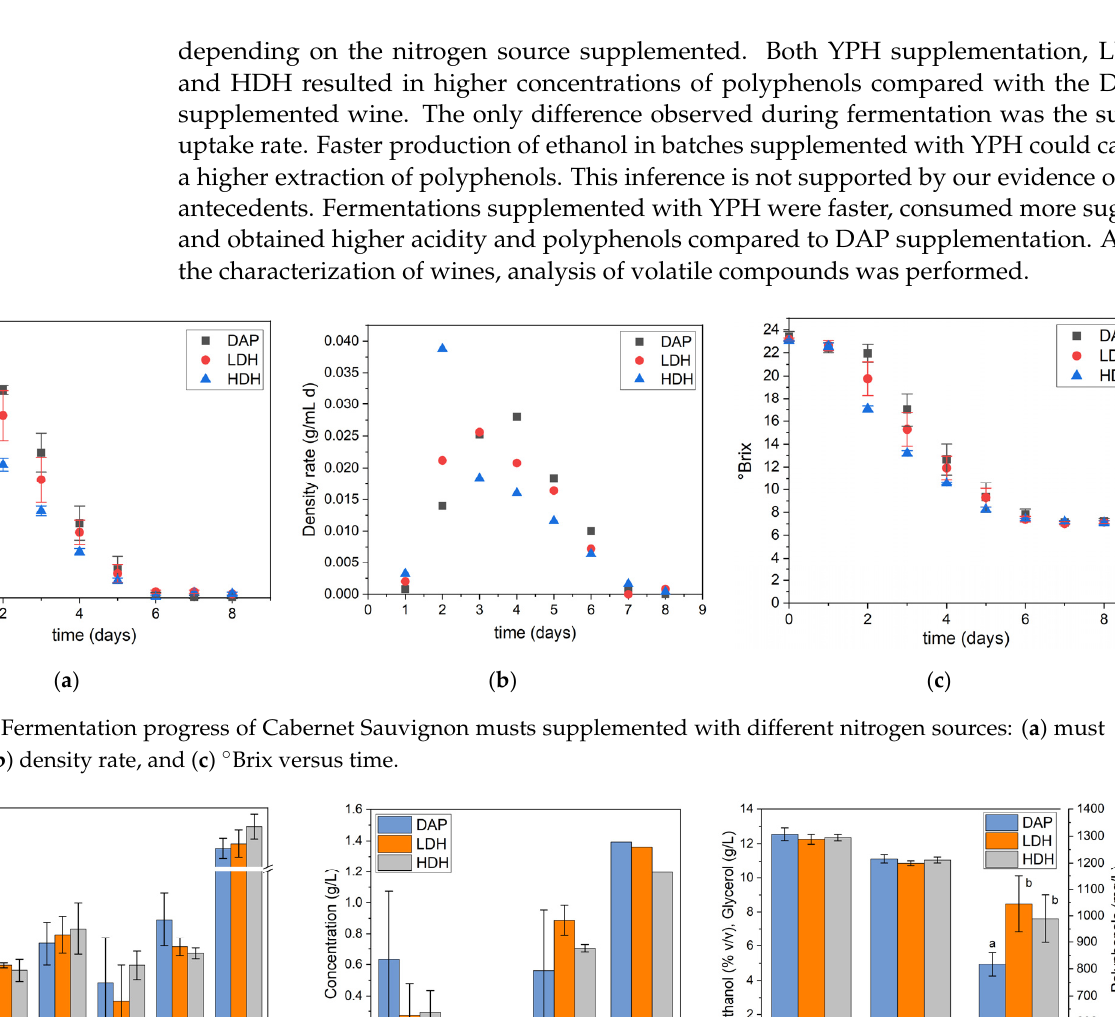
Figure 2. Fermentation progress of Cabernet Sauvignon musts supplemented with different nitrogen sources: ( a ) must density, ( b ) density rate, and ( c ) °Brix versus time.